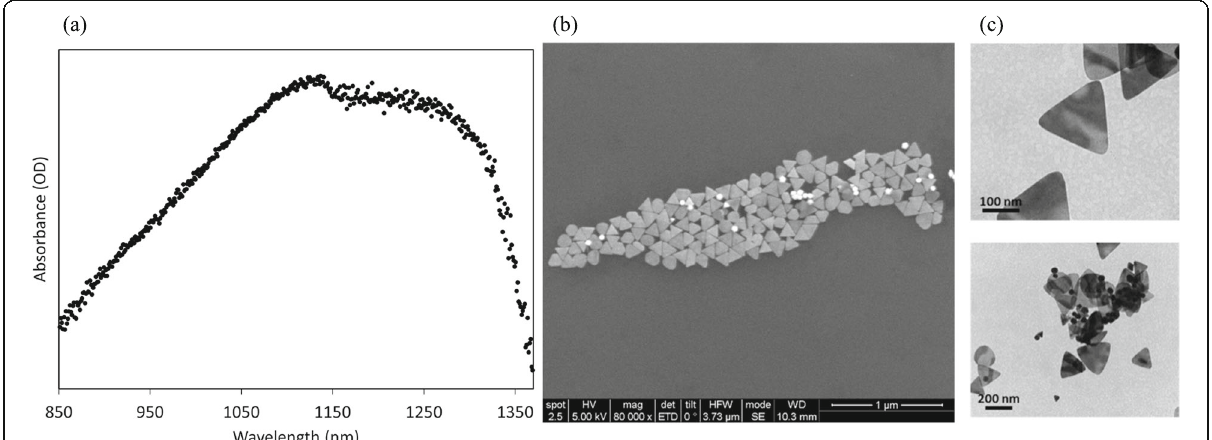
Fig. 2 Characterization of the gold nanoprims. a UV-Vis spectra of the nanoparticles. Representative images of the unconjugated nanoparticles visualized by b SEM and c